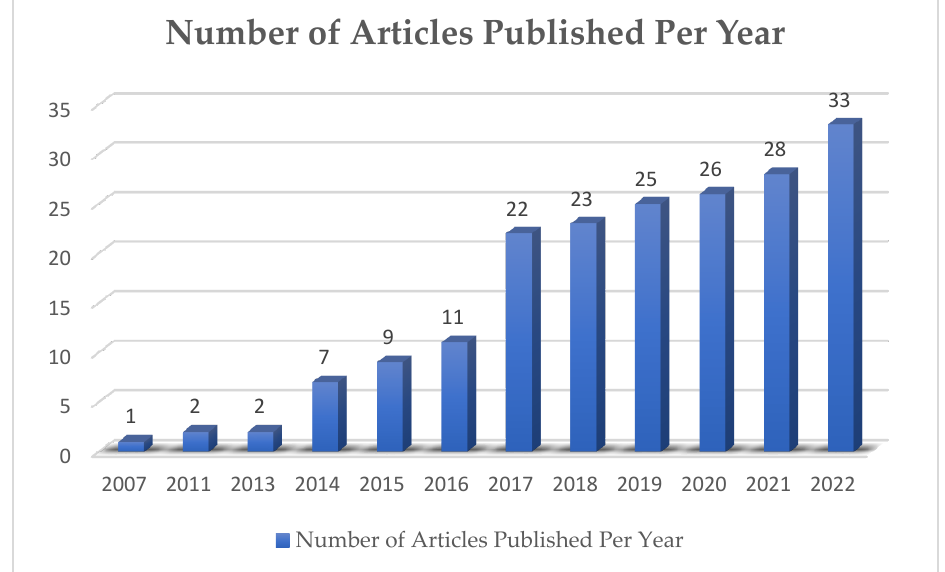
Figure 3. The number of selected articles published per year.